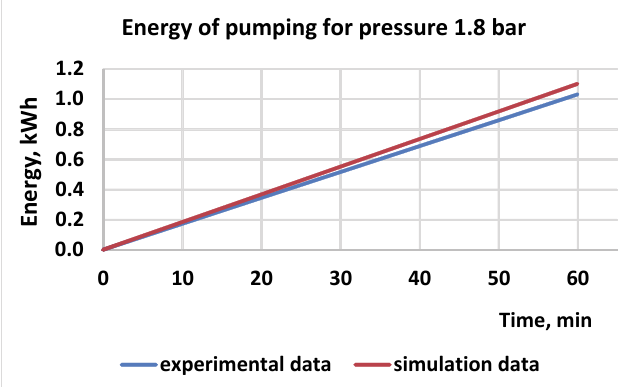
Fig. 8. Consumed power of the centrifugal pump measured by using simulation and experimental